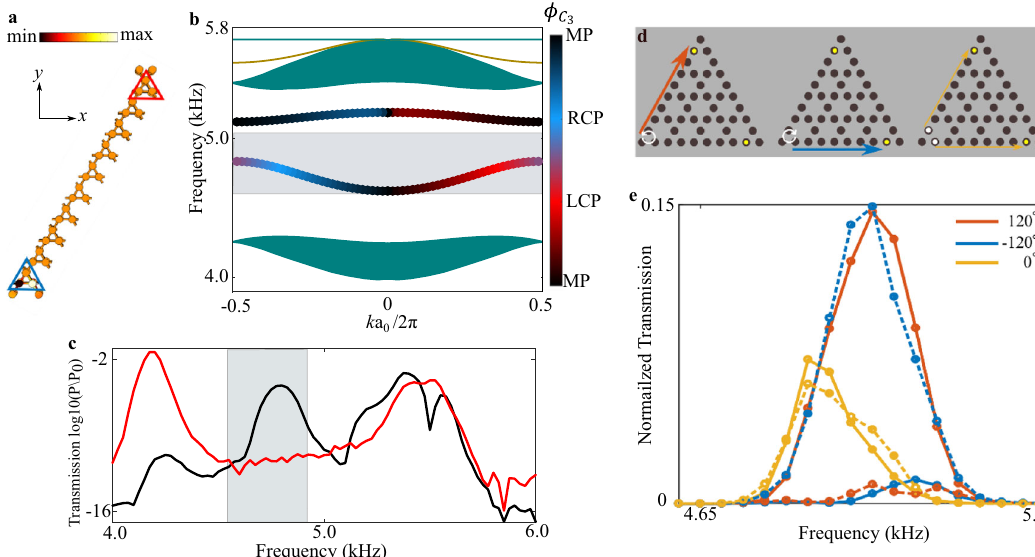
(kHz)4.0 5.0 Frequency c Transmission spectra for the expanded lattice (black line) and shrunken lattice Fig. 4 | Experimental demonstration of angular momentum (pseudo-spin) locking of the edge states. a Field distribution at the lower edge band in a (red line), respectively. The shaded light gray regions in b and c indicate the fre- quencyregionoftheedgestateofinterest. d Schematicsofedgestateexcitationby supercell consisting of 10 cells near k x a 0 = π , the supercell is periodic in the x differentsources;thesources(fromlefttoright)areleft-handedcircularpolarized, directionandterminatedbyaboundarycellinthe y direction. b Bandstructuresof right-handed circular polarized and linearly polarized. Yellow dots are the probing a supercell terminated by cylinderswith halfheight of thetrimers. The dark yellow positions and white dots are the source position. e Normalized transmission linedenotesedgestateslocatedoutsidethebulkbandgap,andtealshadedregions spectra measured at two edges illustrated in d , for phase differences between the are the bands of bulk states. The color encoded in the edge bands represent nor- two sources of 120°, − 120°, and 0°, respectively. Solid and dashed lines are the of the lower (blue) and upper (red) edge band,calculated for the edge malized ϕ C 3 spectra measured at the upper left and bottom right yellow dots in d states of the supercell, denoted by blue and red triangle in a , respectively.